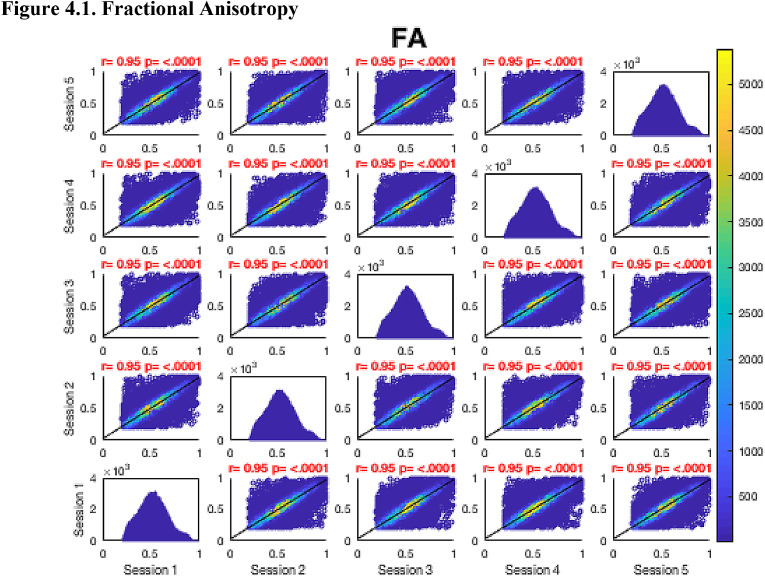
Voxel-wise whole brain white matter Pearson correlations are presented between individual time points for voxels pooled across all subjects, r = Pearson correlation coefficient, p < .0001 for all plots. Fig. 4.1 Fractional Anisotropy (FA), Fig. 4.2 Mean Diffusivity (MD), units = 10−3 mm2/s, Fig. 4.3 Radial Diffusivity (RD), units = 10−3 mm2/s, Fig 4.4 Restricted Signal Fraction (RSF), Fig. 4.5 Macromolecular Proton Fraction (MMPF), Fig. 4.6 Myelin Water Fraction (MWF), Fig. 4.7 Longitudinal Relaxation Rate (R1), units = s−1, Fig. 4.8 Magnetisation Transfer Ratio. For the 2D scatter plots, the colour scale denotes the number of voxels in each joint histogram bin. The univariate histograms  on the diagonal show the distributions of voxels of a given metric across all voxels (subject to the inclusion criteria described in ‘Methods’) for each scan.